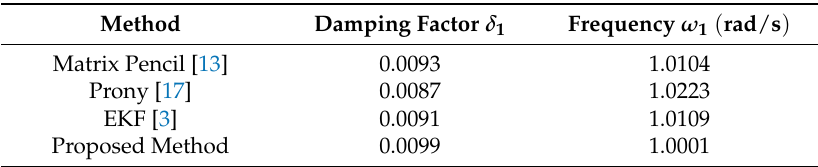
Table 1. Identified results of different